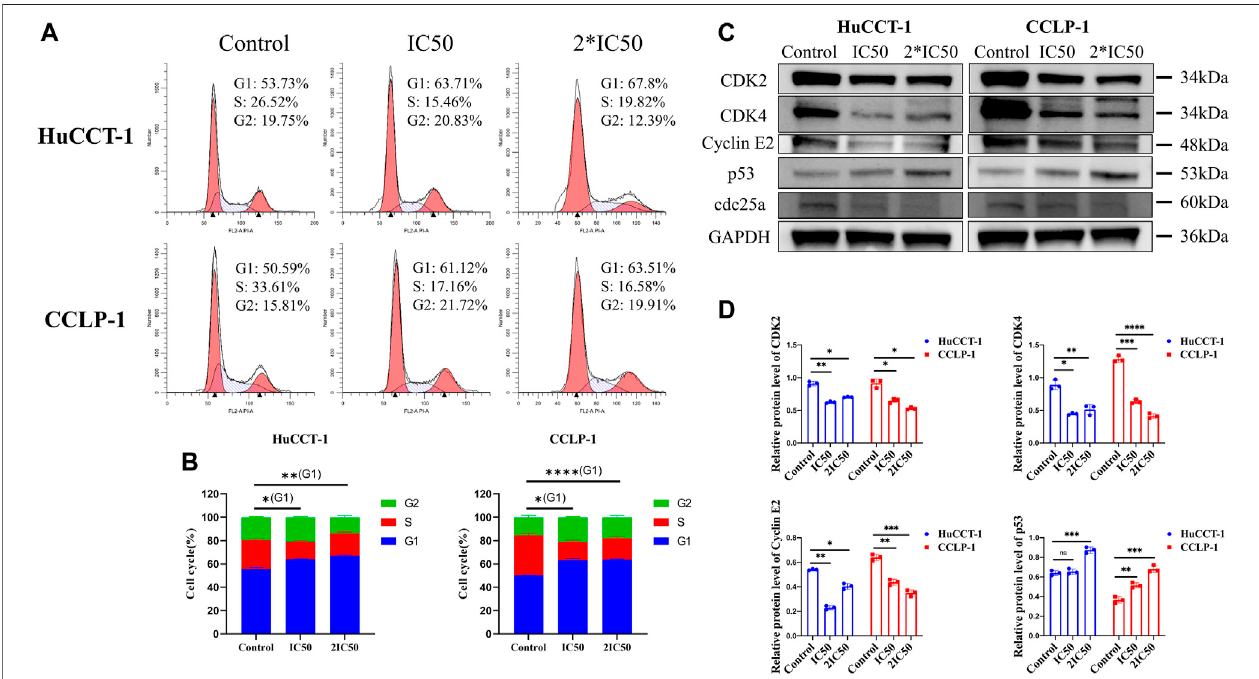
FIGURE 3 | Silibinin induced G1 arrest in cholangiocarcinoma. (A,B) . Cholangiocarcinoma cell cycle distribution was determined using FCM analysis after treatment with IC50 and 2*IC50 concentrations of silibinin. The histograms show the percentage of HuCCT-1 and CCLP-1 cells in each phase. (C,D) . Western blotting results of G1 checkpoint proteins. Cells were treated with IC50 and 2*IC50 concentrations of silibinin for 48 h. The quanti fi cation results of CDK2, CDK4, Cyclin E2 and p53 are demonstrated by histograms. Data are shown as mean ± SD, * p < 0.05 , ** p < 0.01 , *** p < 0.001 , **** p < 0.0001 , signi fi cantly difference compared with control